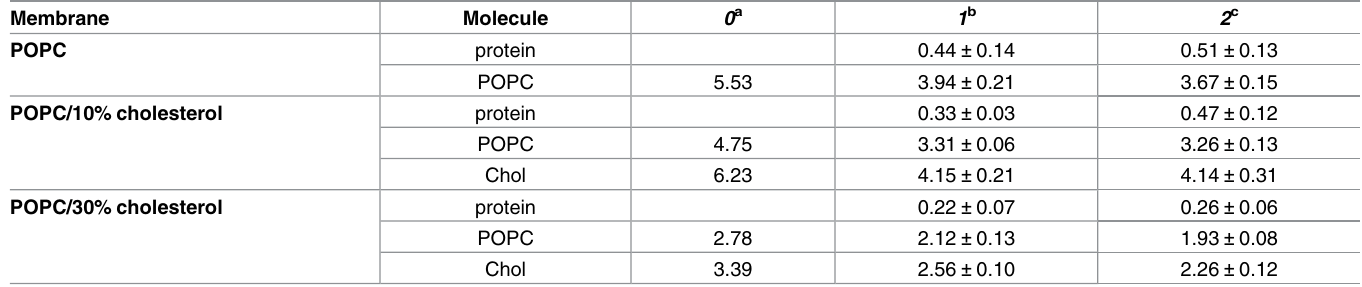
averaged over the trajectories of each molecule, using the Einstein relation (see Table 4):